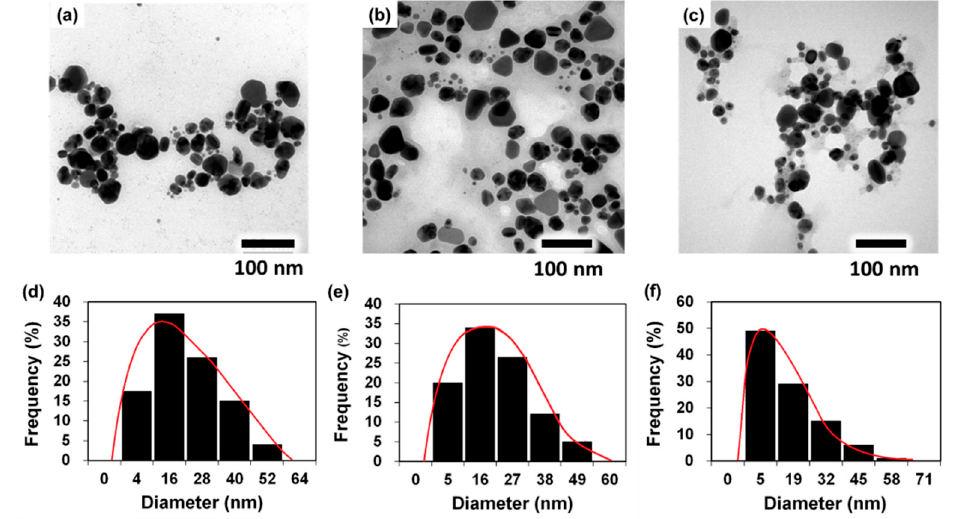
Figure 3. TEM images of P.uri.AgNP ( a ), P.zey.AgNP ( b ), and S.dul.AgNP ( c ); the graph of dimension distribution of P.uri.AgNP ( d ), P.zey.AgNP ( e ), and S.dul.AgNP ( f ). 3.3. Antifungal Activities of P.uri.AgNPs, P.zey.AgNPs and S.dul.AgNPs P.uri.AgNPs, P.zey.AgNPs, and S.dul.AgNPs were tested for antifungal ability against A.